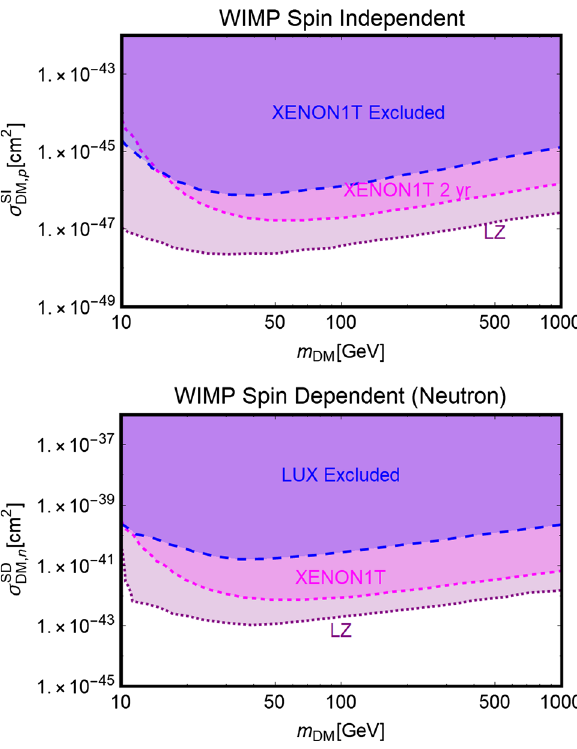
Fig. 4 Limits (by LUX) and projected sensitivities (by XENON1T and LZ) adopted in this study for SI (top panel) and SD (bottom panel) interactions in the bi-dimensional plane (DM mass, cross-section). For SI interactions we have reported, as usual, the scattering cross-section of the DM on protons; for SD we have, instead, considered scatter- ing on neutrons since we are considering “Xenon based” detectors. The blue region are, respectively, currently excluded by LUX while the magenta/purple regions will be excluded in case of absence of signals at